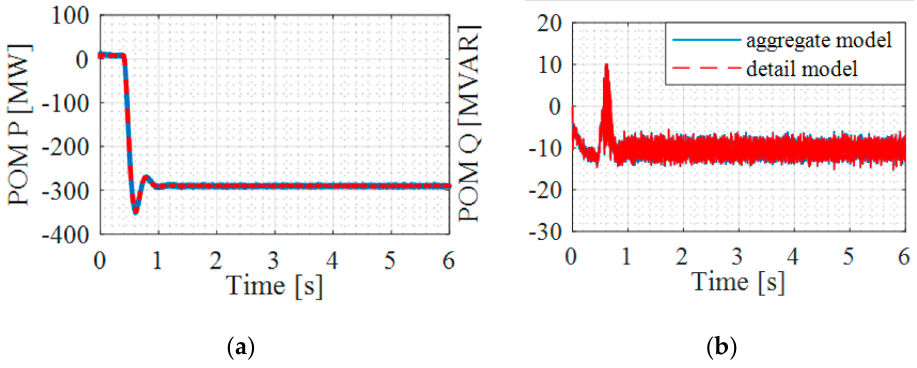
Figure 11. Active and reactive power at the POM for Case 1 using aggregated and detailed models: ( a ) Active power, ( b ) Reactive Power. Table 3. THD comparison between aggregate and detail model at POM.